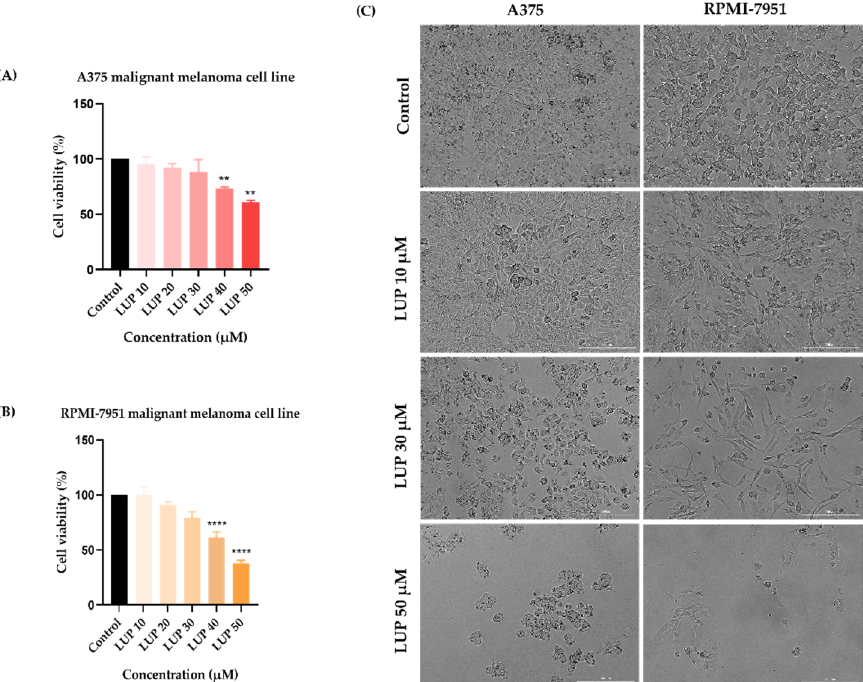
Figure 1. In vitro assessment of the effect LUP (10, 20, 30, 40 and 50 µM) exerts on the viability of ( A ) A375 and ( B ) RPMI-7951 MM cells after 24 h of treatment by applying the MTT assay and ( C ) morphology and confluence of A375 and RPMI-7951 MM cells following the 24 h treatment with LUP 10, 30, and 50 µM. The data are expressed as viability percentages (%) normalized to control cells and expressed as mean values ± SD of three independent experiments performed in triplicate. To identify the statistical differences between the control and the LUP-treated group, a one-way ANOVA analysis was conducted followed by the Dunett’s multiple comparisons post-test (** p < 0.01; **** p < 0.0001). The image scale bars indicate 200 µm.